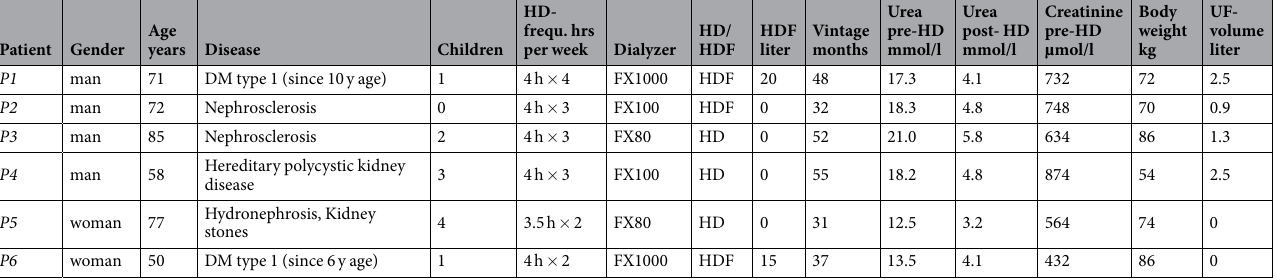
Table 2. Patient characteristics of the patients included in the study. Details about hemodialysis procedure are shown. DM = diabetes mellitus, HD = hemodialysis, HDF = hemodiafiltration. UF = ultrafiltration. Urea in